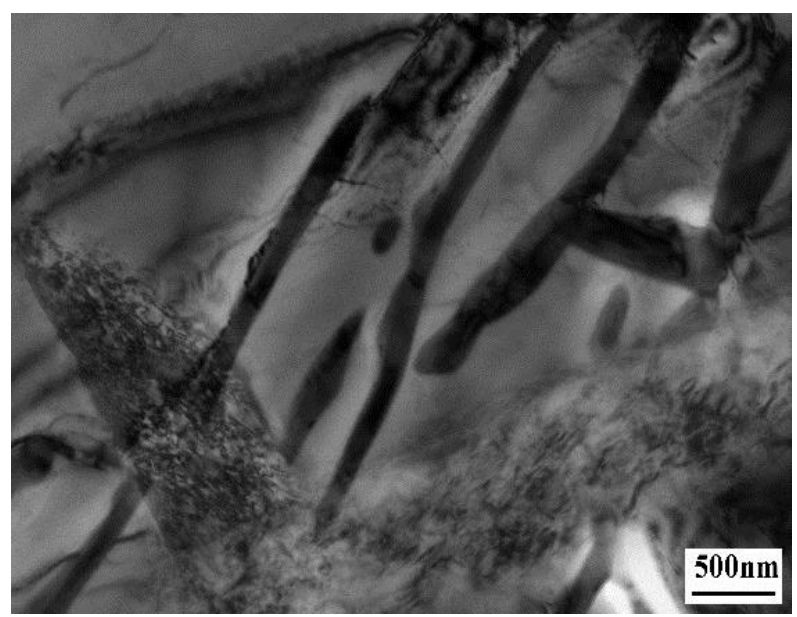
Figure 15. TEM morphology of acicular ferrite in 0.0061% Zr weld metal.